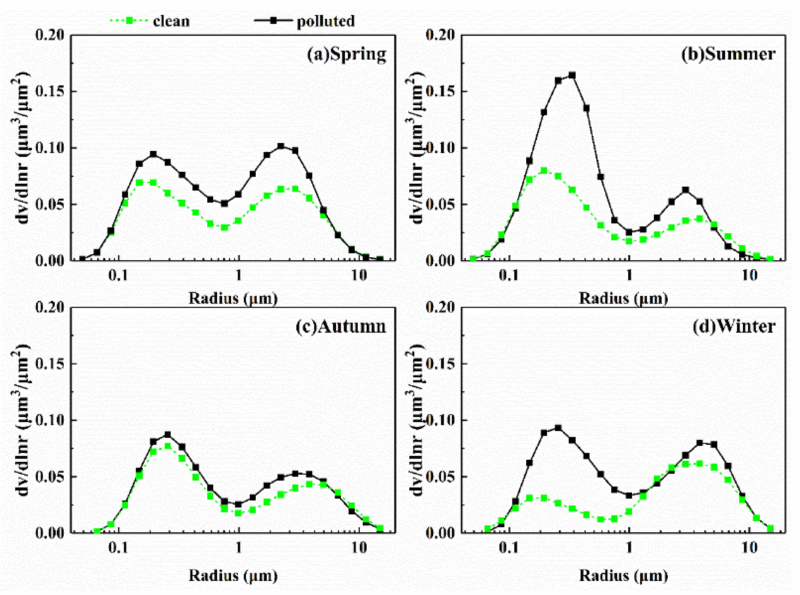
Figure 6. Multi-year seasonal mean of the volume size distribution (VSD) in ( a ) spring; ( b ) summer; ( c ) autumn; ( d ) winter over Wuhan, China under different particulate air pollution conditions from 2013 to